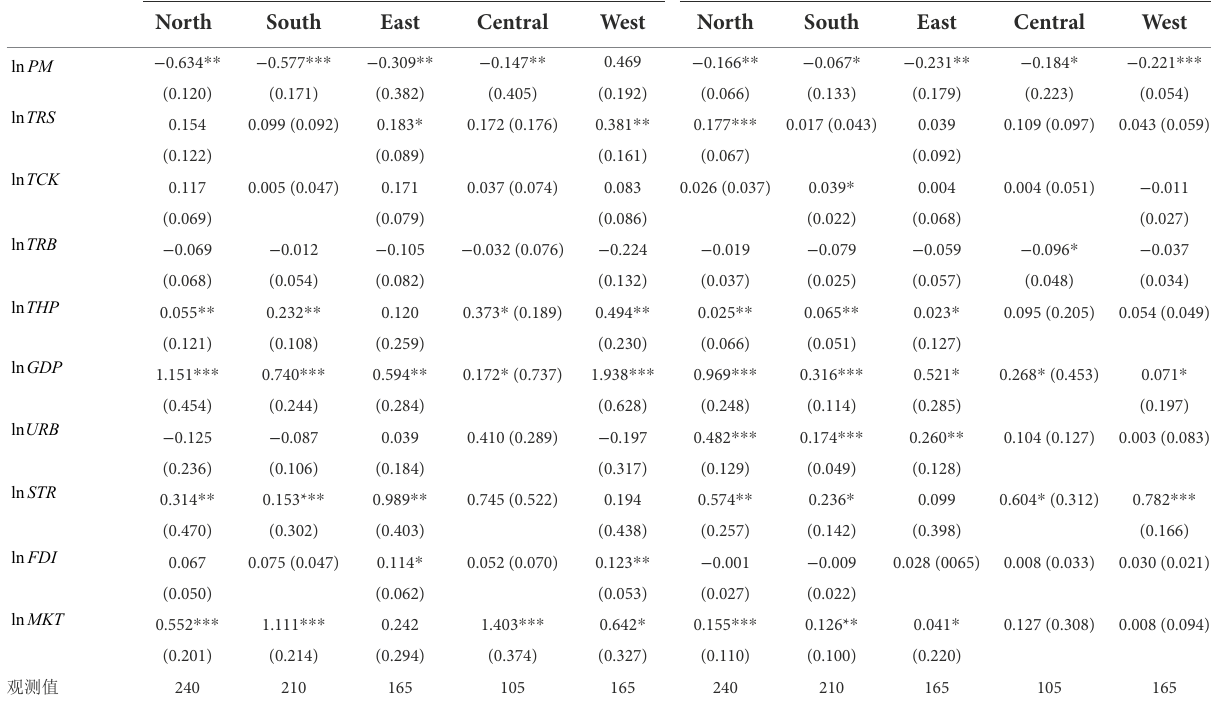
TABLE 2 Regional estimation